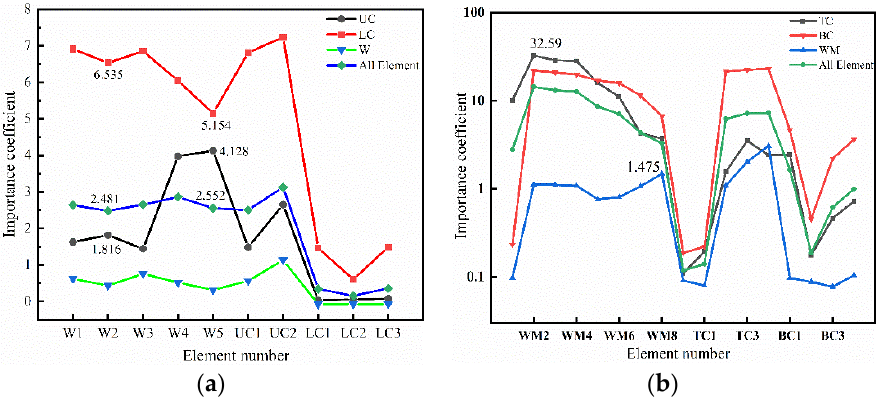
Figure 10. Importance coefficient: ( a ) Test truss, ( b ) steel roof truss.